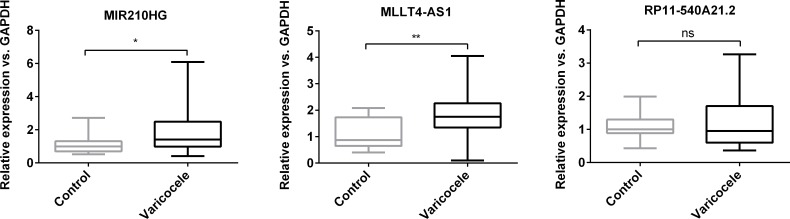
Long non-coding RNA (lncRNA) expressions in the varicocele and control groups.Boxplots of the expression levels of lncRNAs MIR210HG, MLLT4-AS1, and RP11-540A21.2 in the ejaculated spermatozoa from the varicocele group compared to the control groups (P = 0.0307 for MIR210HG; P = 0.0061 for MLLT4-AS1; P = 0.4111 for RP11-540A21.2; two-tailed sample t-test; ns: not significant). Levels of expression were normalized relative to GAPDH.